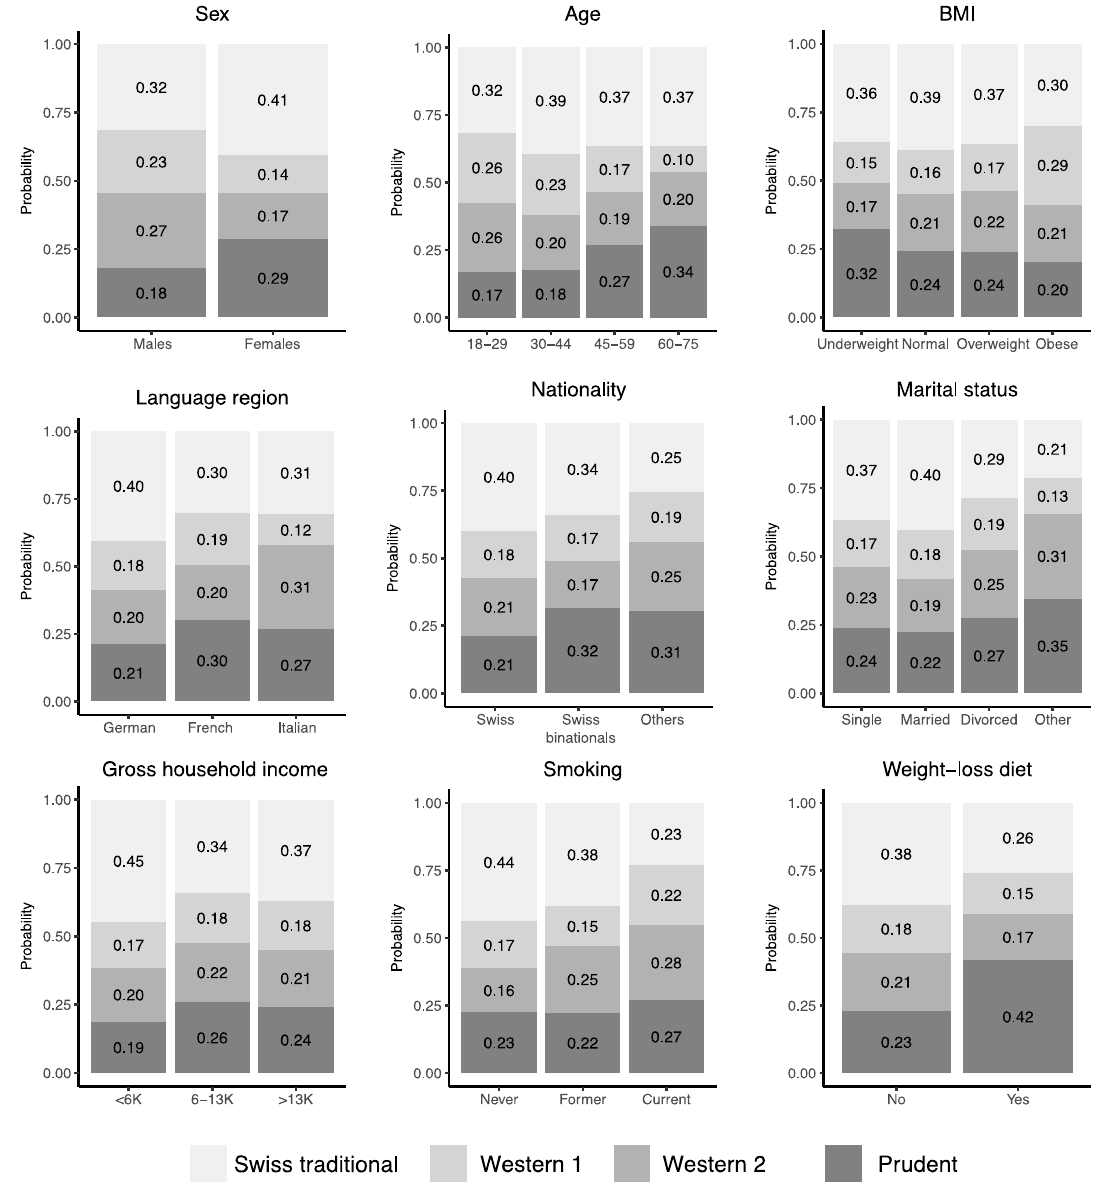
Figure 4. Effect plots of the main determinants of dietary patterns in Switzerland. Stacked bar plots indicate the probability for individuals to follow a dietary pattern as predicted by the multinomial logistic regression model (sex, age groups, BMI, language region, nationality, education, marital status, gross household income, self-reported physical activity, smoking, self-reported health, and weight-loss diet; all results are described in Table 2). Abbreviation: BMI, Body Mass Index.